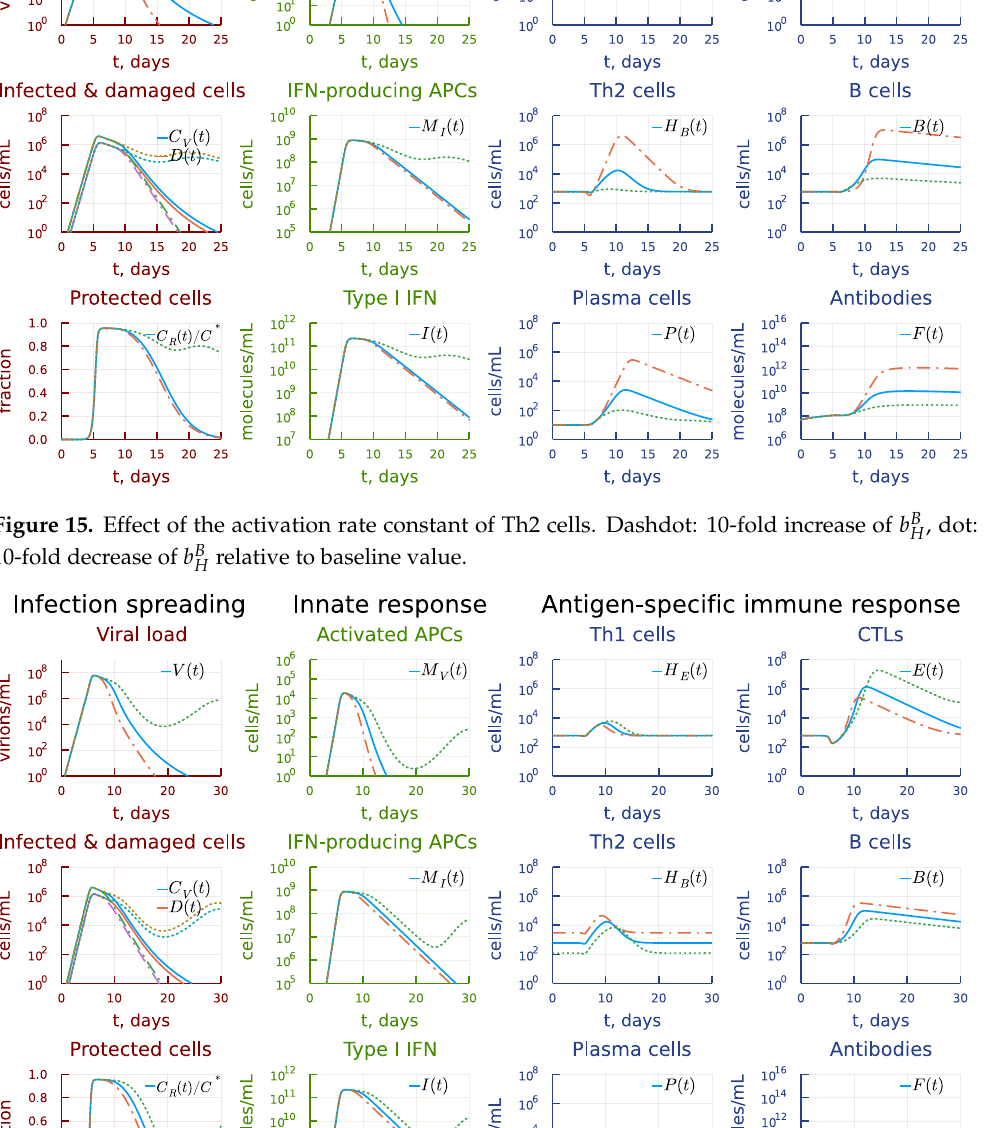
Figure 16. Effect of the homeostatic concentration of SARS-CoV-2 specific Th2 cells. Dashdot: 5-fold increase of H ∗ , dot: 5-fold decrease of H ∗ relative to baseline B B